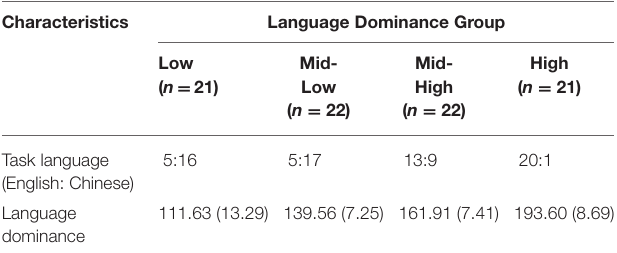
TABLE 3 | Overview of language dominance groups’ participant composition and language dominance scores (corresponding to task language condition), with means and standard deviations